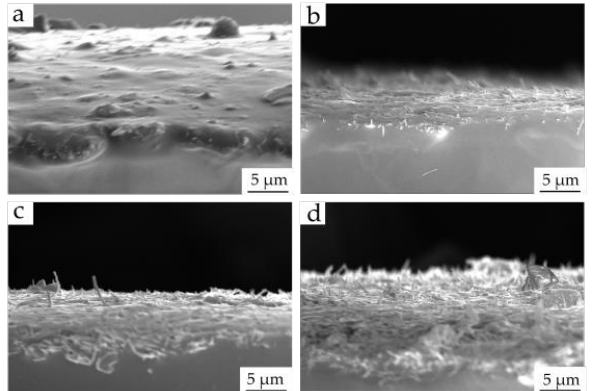
Figure 2. SEM images of AgNWs/PDMS films with different mass ratios of PDMS main agent and